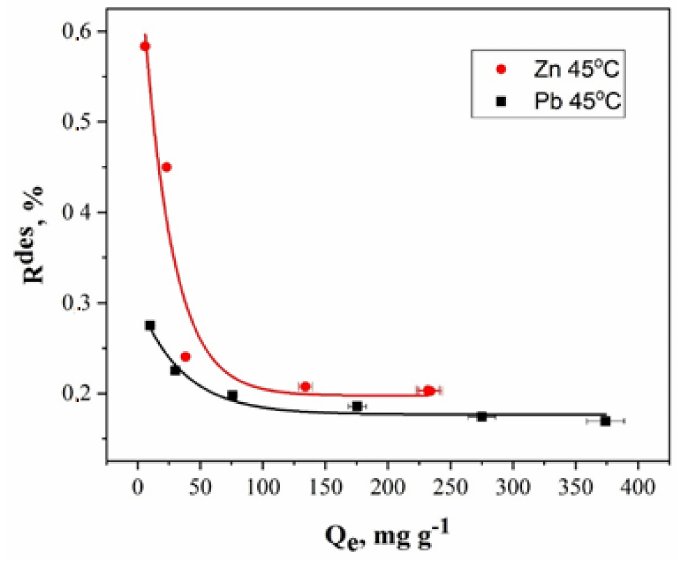
Figure 15. Dependence of the desorption on the nanocomposite adsorption capacity toward the Zn and Pb ions.